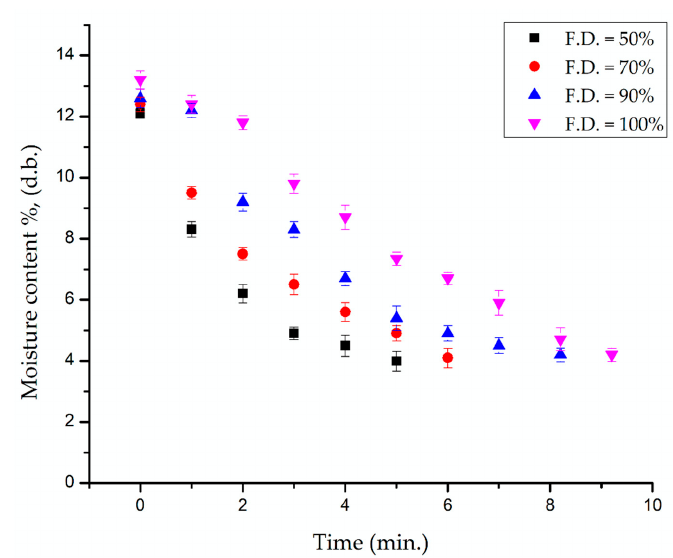
Figure 10. Baking times for 3D-printed cookies with different fill density values with a water butter ratio of 3:10 printed at 27 °C.